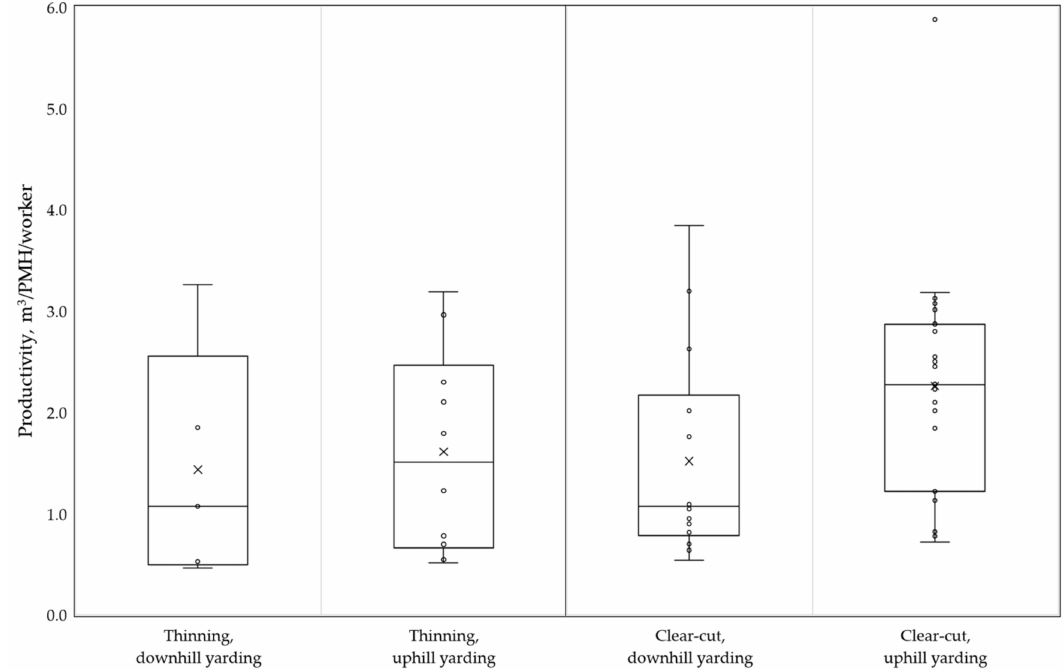
Figure 4. Changes in productivity evaluated for uphill and downhill yarding activities under different silvicultural treatments: average yarding distances of 64 and 72 m in thinning and 77 and 64 m in clear-cut, respectively. The circles are data points, and the × is the mean value.